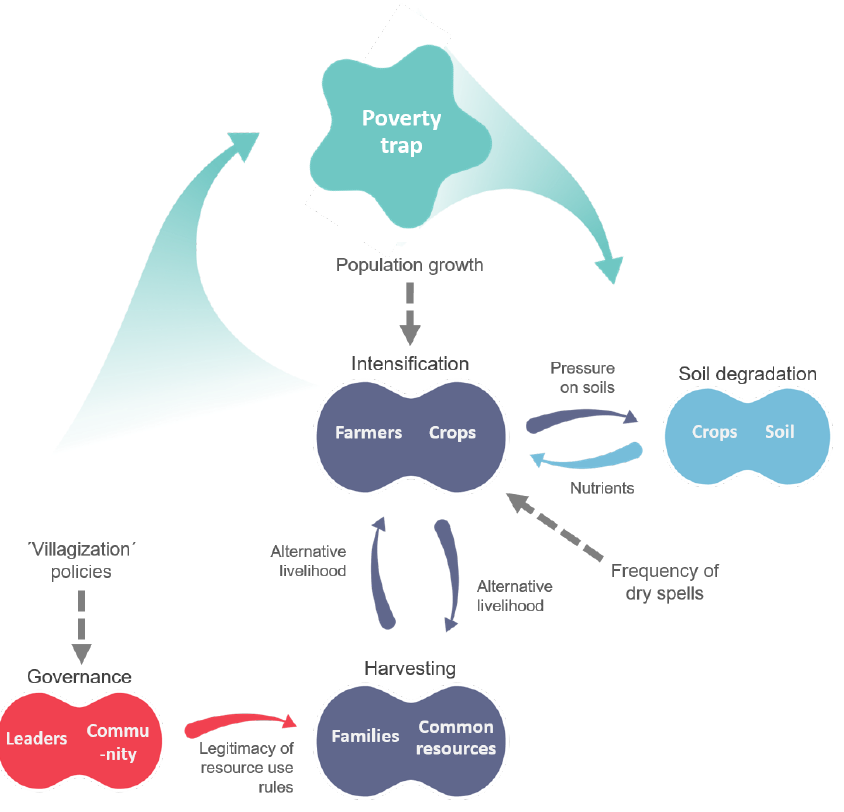
Figure A4: SE-AS representation of the configuration of social-ecological (dark blue), ecological (light blue) and social action situations (red) hypothesized to explain the emergence of a poverty trap in